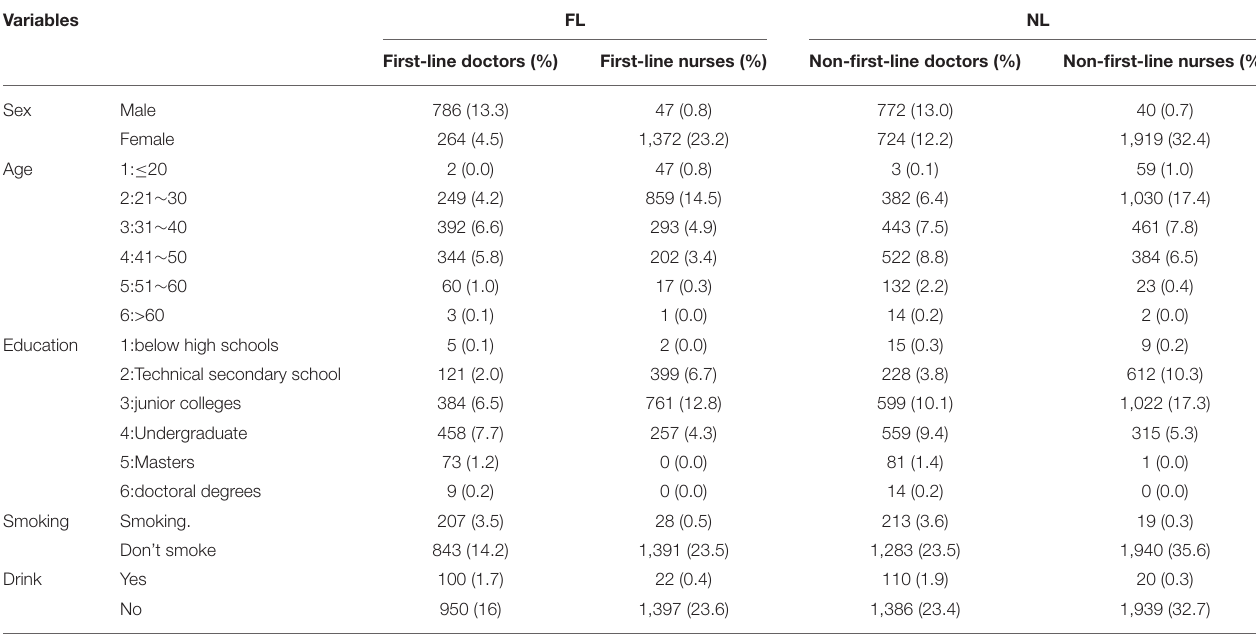
FL, front-line medical staff; NL, non-front-line medical staff.